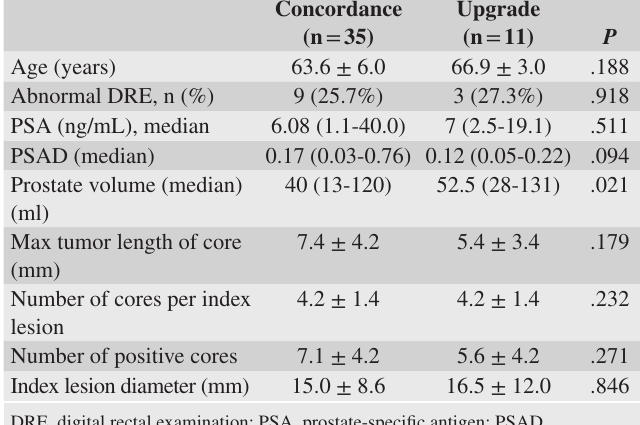
Table 6. Univariate Analysis of the Possible